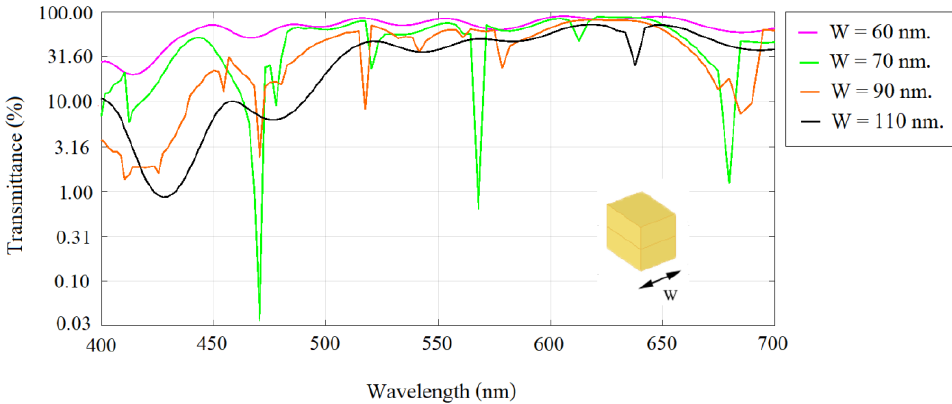
Figure 2. Transmittance when W is varied from 10 to 110 nm.